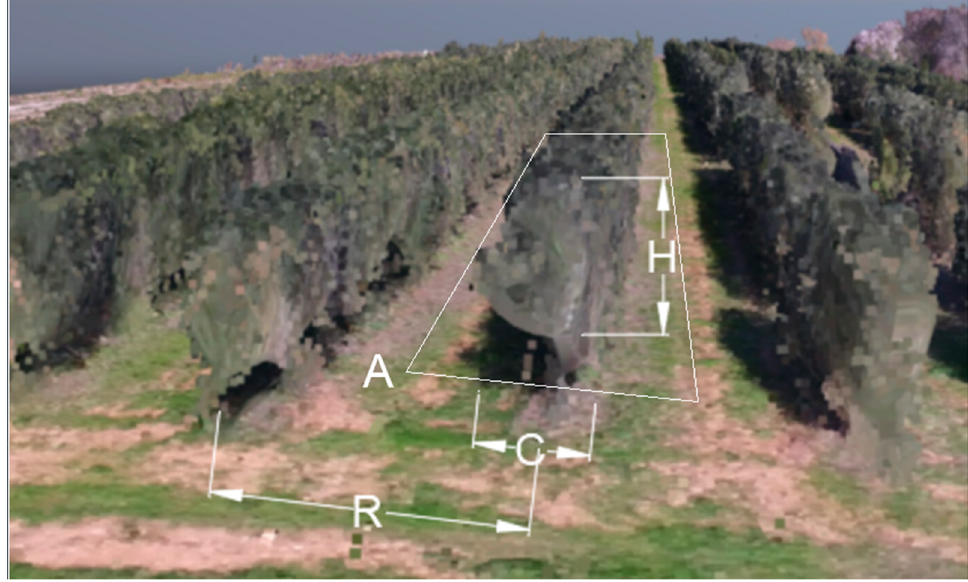
Figure 7. Tree crown geometry for the TRV 3 estimation method.